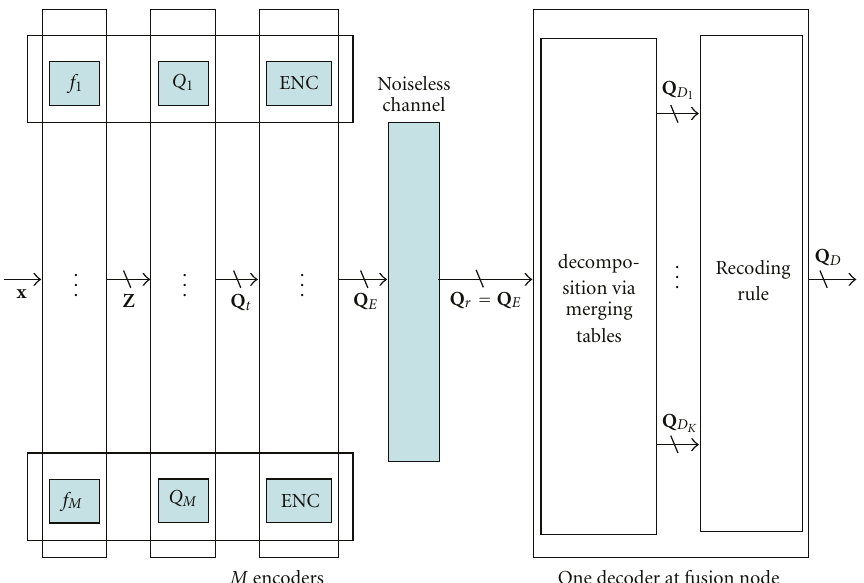
Figure 4: Encoder-decoder diagram: the decoding process consists of decomposition of the encoded M -tuple Q E and decoding rule of computing the decoded M -tuple Q D which will be forwarded to the localization routine.